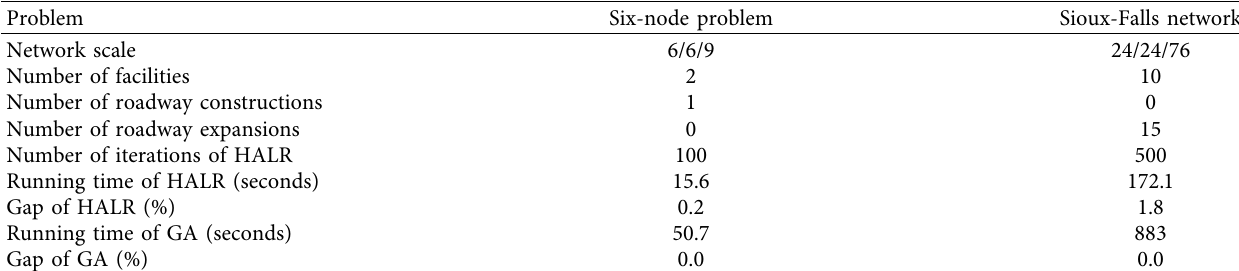
Table 2: Computational result performance analysis.